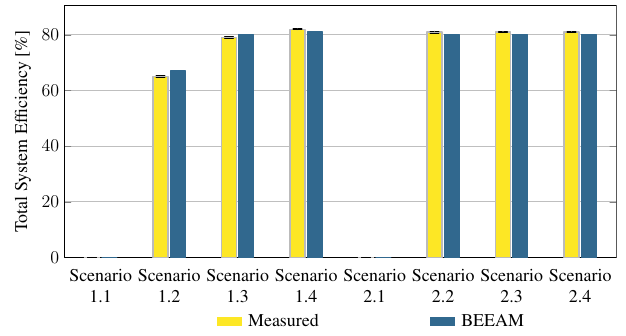
Figure 17. Predicted versus measured total system efficiencies, Scenarios 1 and 2.